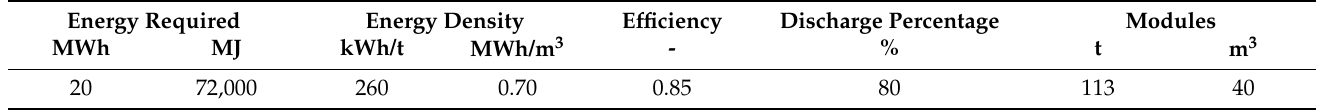
Table 11. Properties of the battery modules.